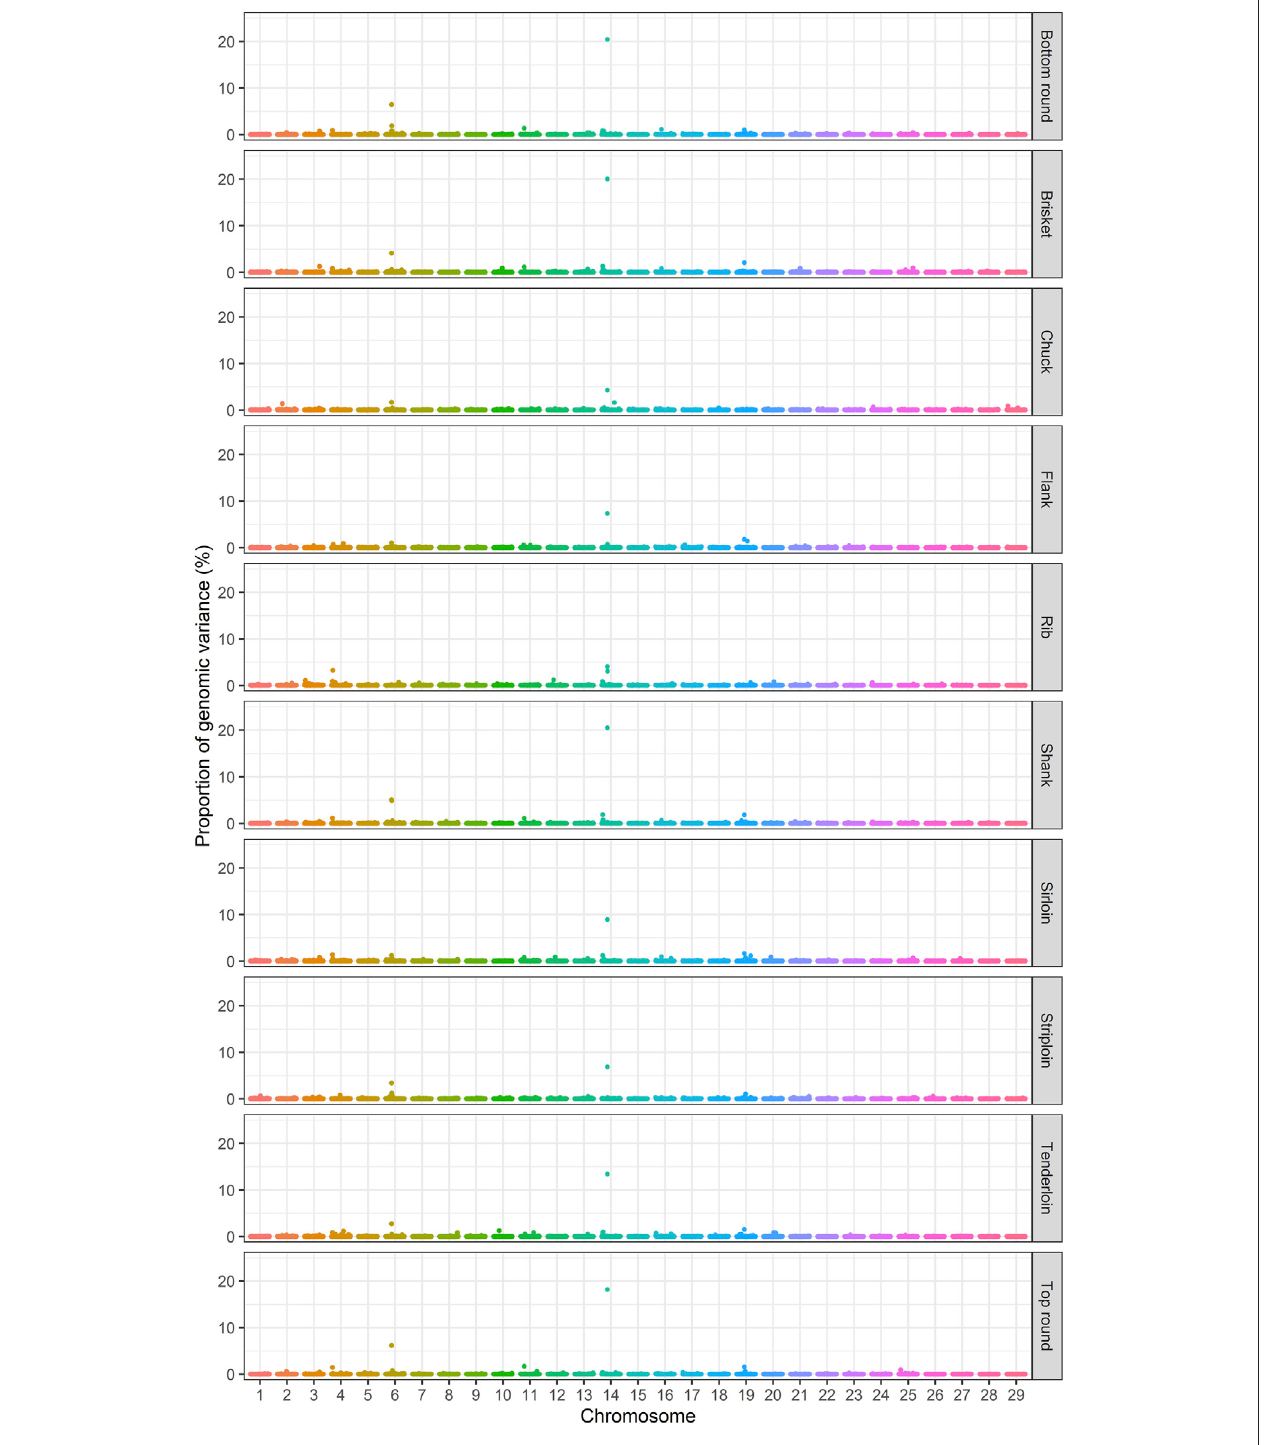
FIGURE 1 | Manhattan plots of the percentage of genomic variance explained by 1-Mb windows for primal cut traits in Hanwoo cattle.